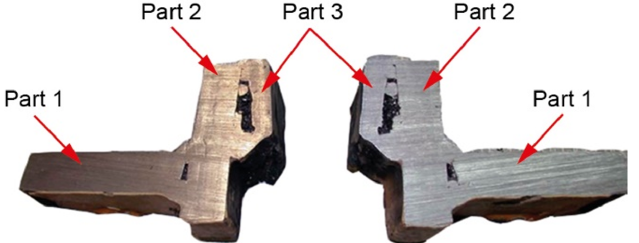
Figure 28. The cross-cut surface. Weld seam defects are shown (handy-size bulk carrier 30210 DWT). Macroscopic examination.